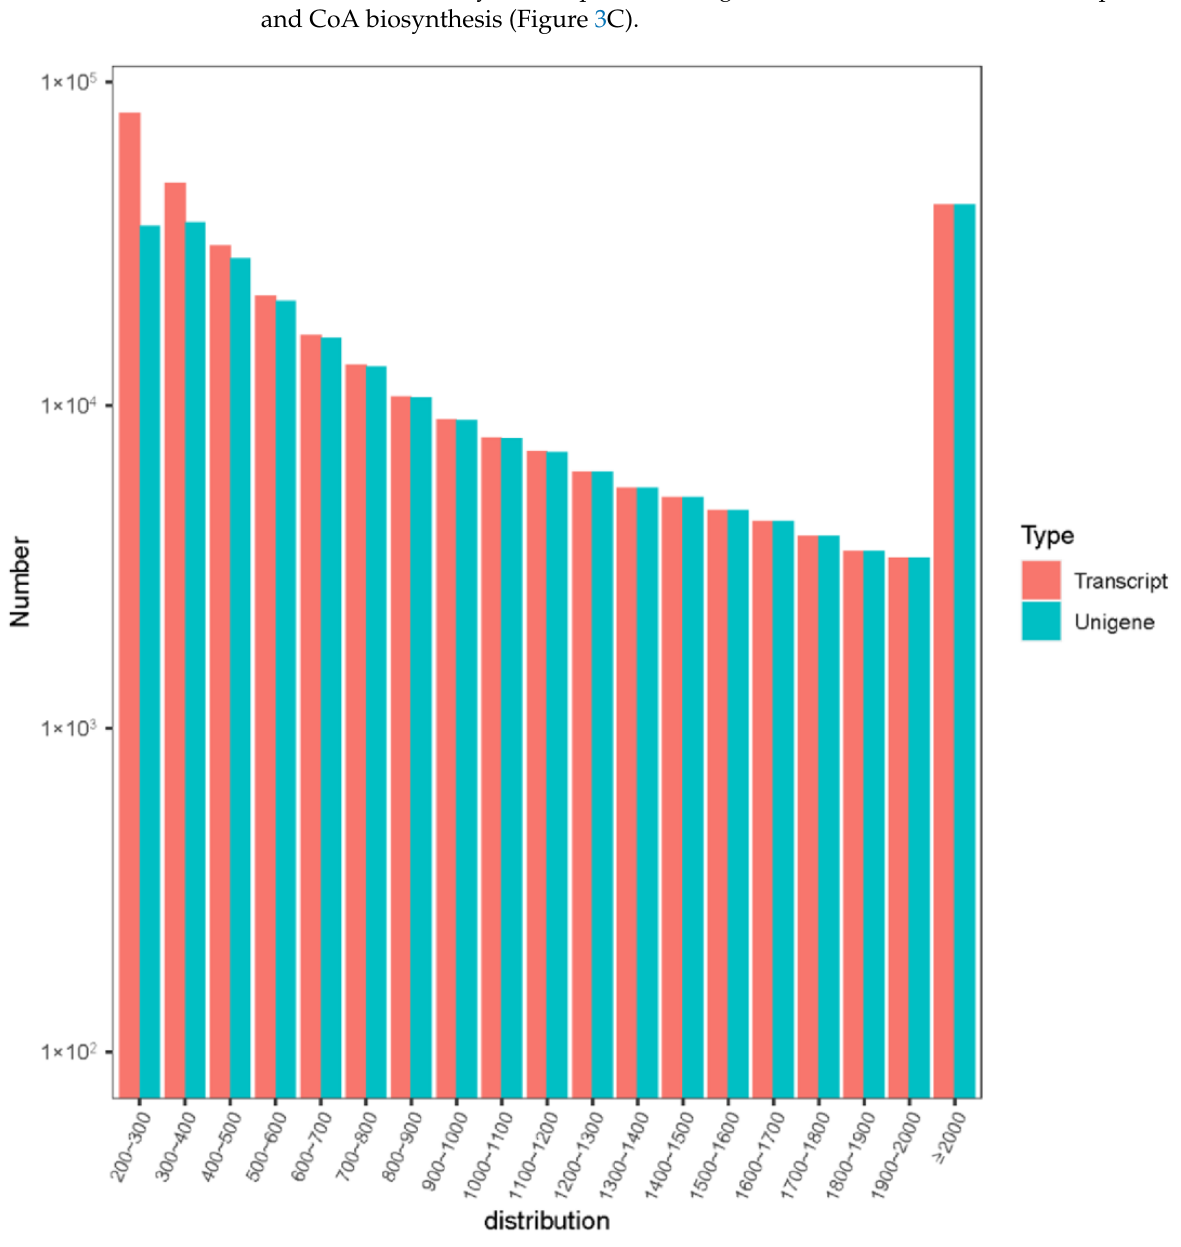
Figure 2. Splicing sequence length distribution map of Korean pine